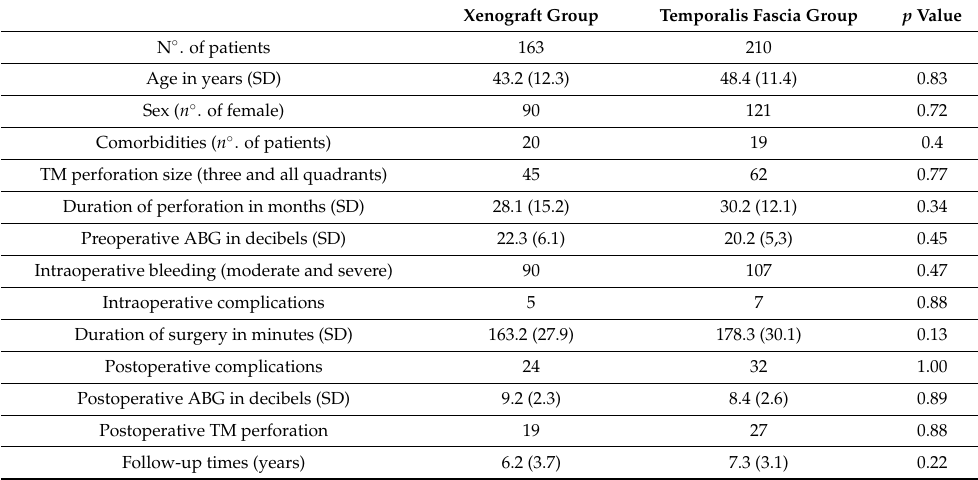
Table 1. Clinical/surgical characteristics and the outcome of chronic otitis media patients treated with tympanoplasty.